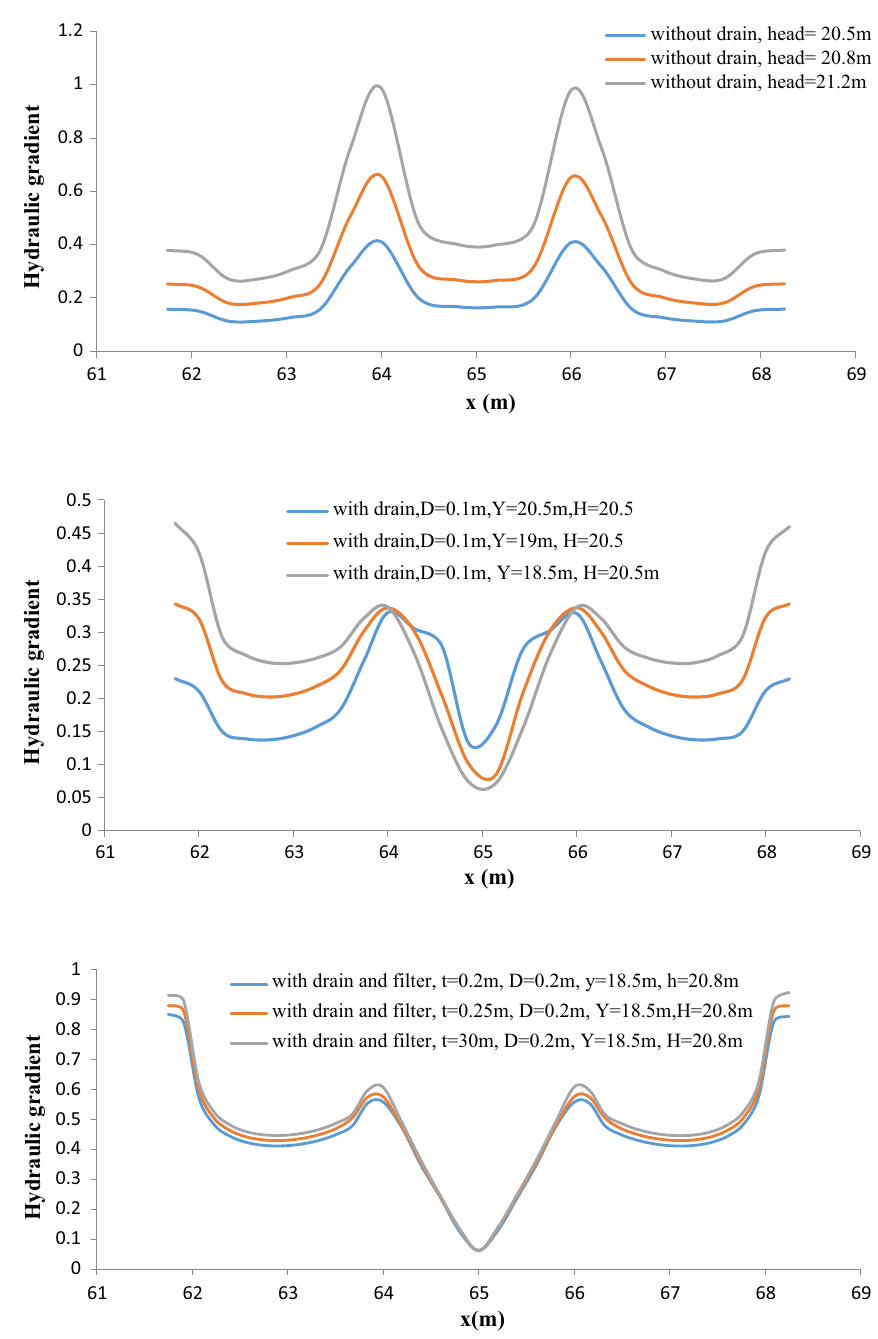
with drain and filter, t=0.2m, D=0.2m, y=18.5m, h=20.8m with drain and filter, t=0.25m, D=0.2m, Y=18.5m,H=20.8m with drain and filter, t=30m, D=0.2m, Y=18.5m,